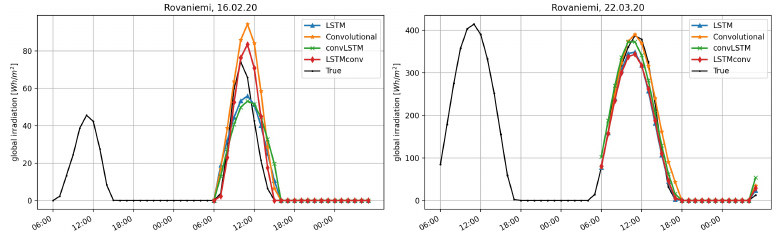
Figure 11. Global irradiation forecasts for Rovaniemi on 16 February 2020 (left) and 22 March 2020